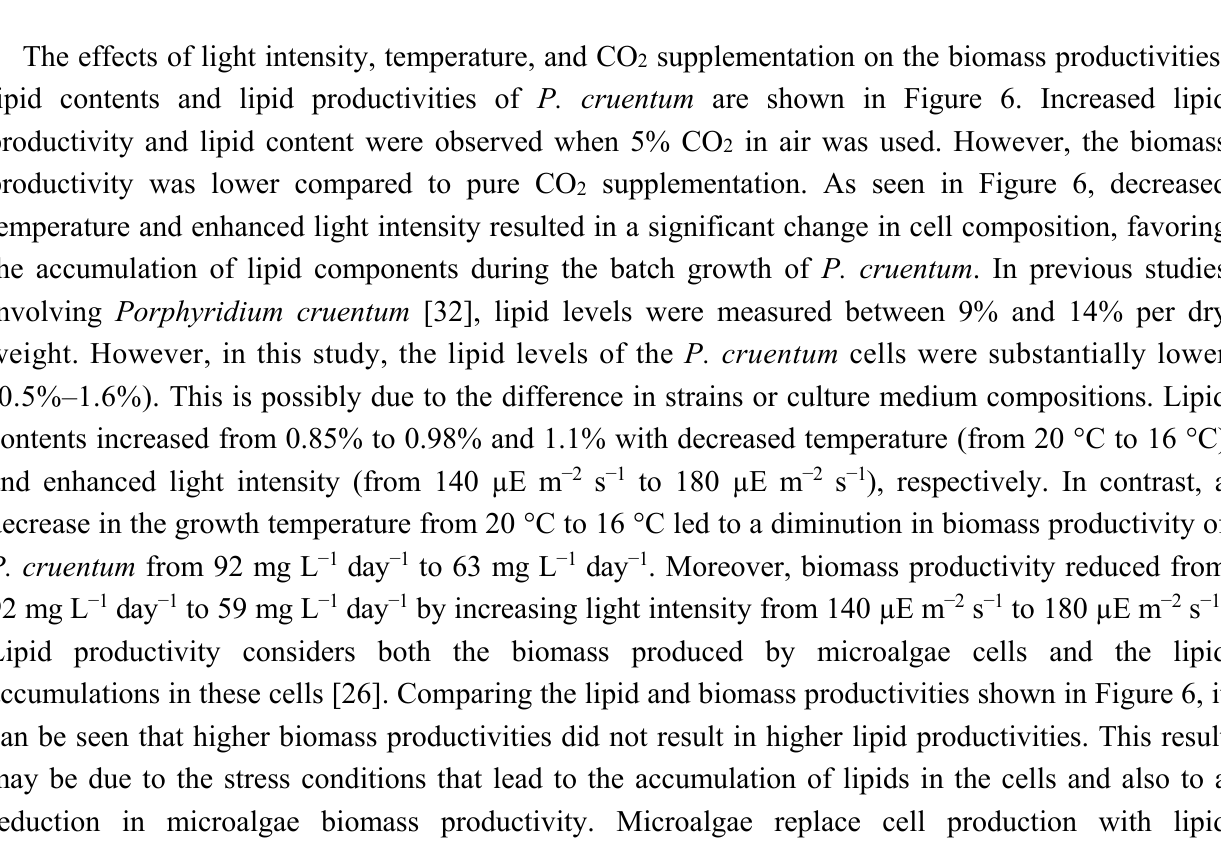
Figure 5. The effect of temperature and light intensity as well as CO 2 supplementation on growth rates (µ) of P. cruentum